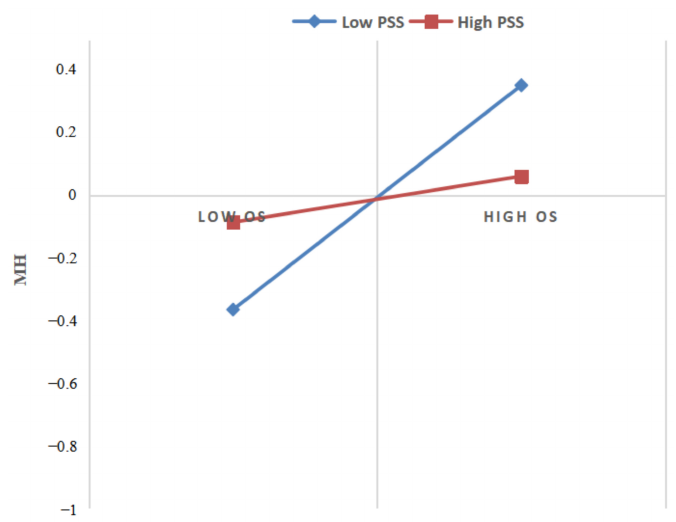
Figure 3. Simple slopes of occupational stress and mental health for referees with low and high levels of perceived social support. OS: occupational stress; PSS: perceived social support; MH: mental